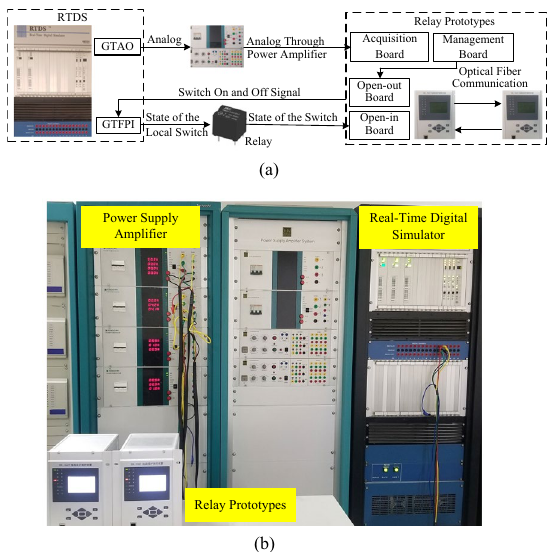
Fig. 12 Test platform structure: a Schematic; b Actual